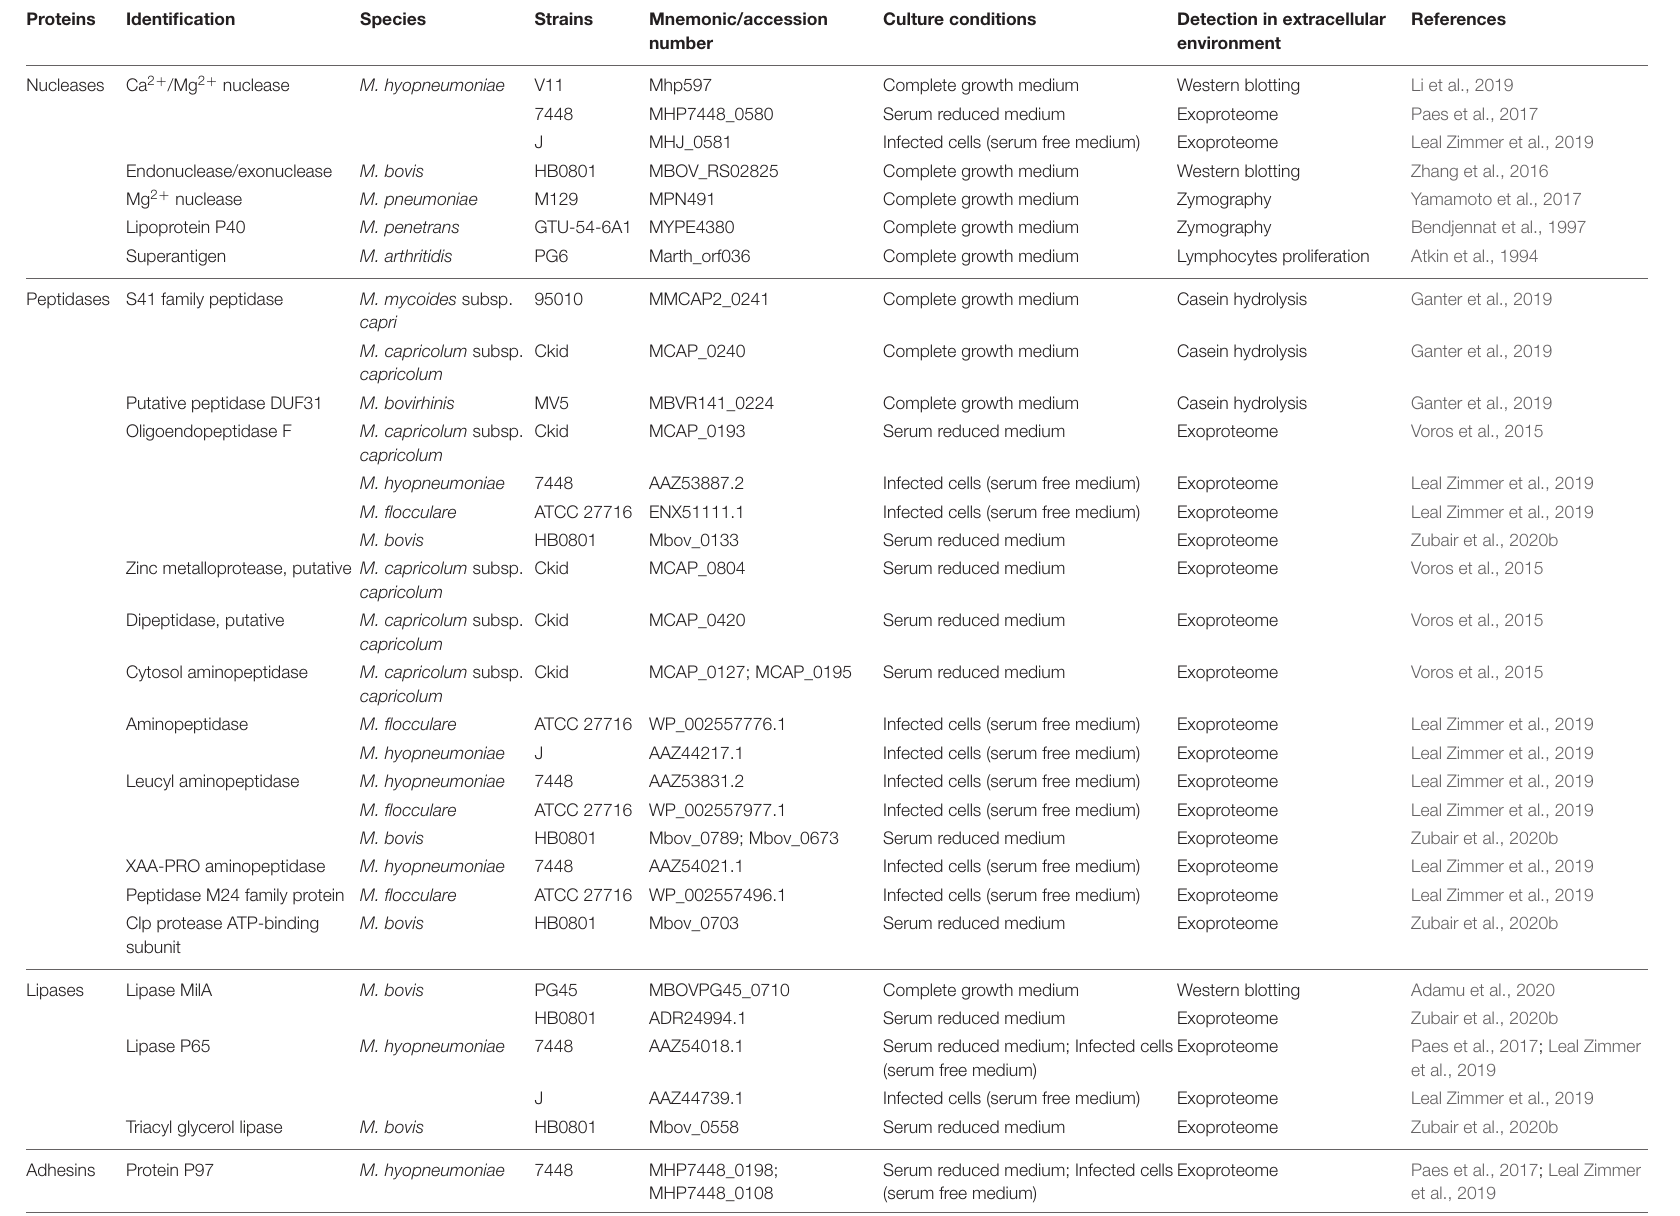
TABLE 1 | Non-exhaustive list of exoproteins with known functions released by Mycoplasma (sub)species.